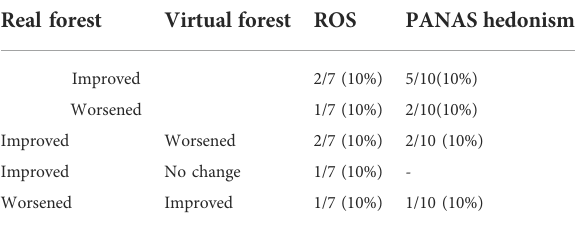
TABLE 4 Binary comparison of change in relaxation and emotional state in participants who attended both sessions. Real